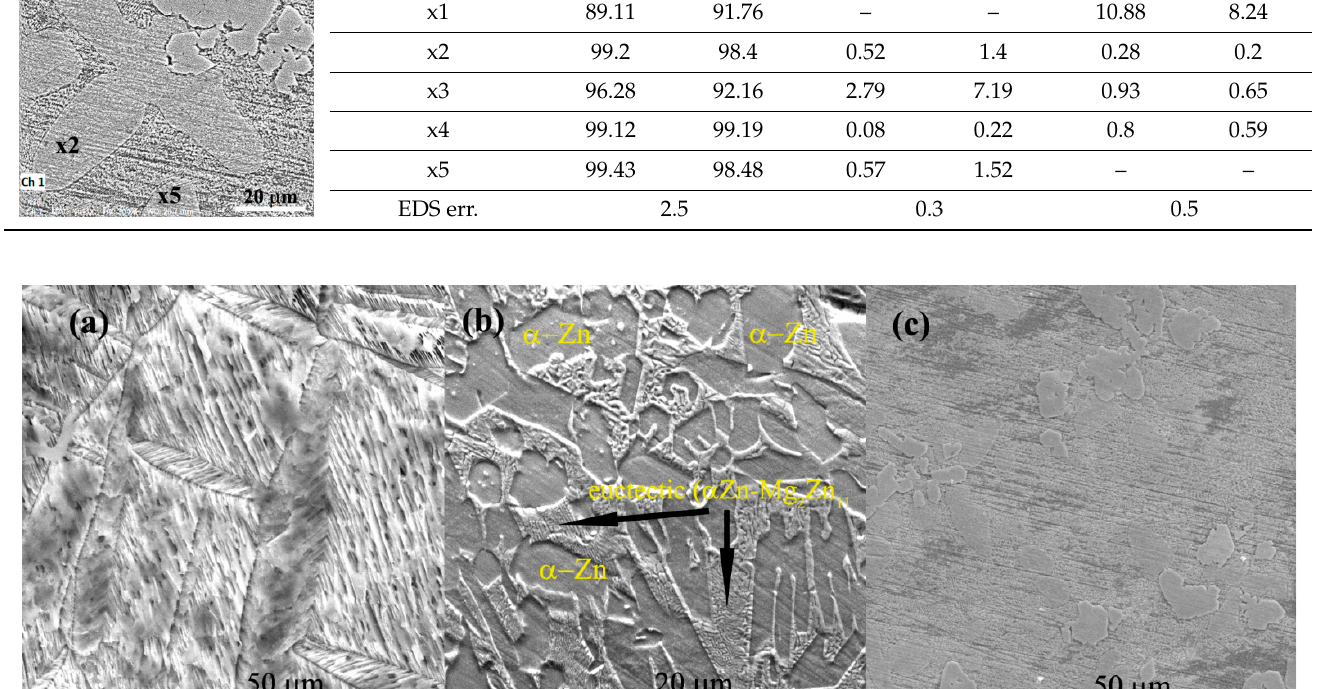
Figure 3. Structural aspects of the samples before corrosion tests ( a ) Zn, ( b ) ZnMg, and ( c ) ZnMgY.